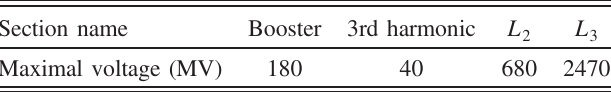
TABLE I. Maximal accelerating voltage in rf sections.